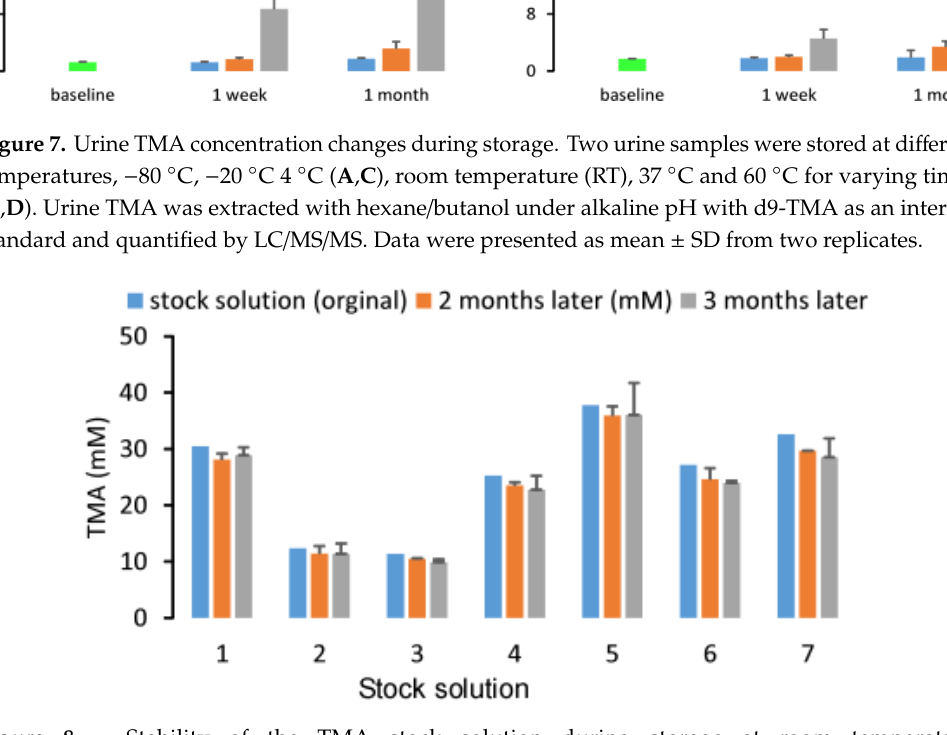
Figure 9. Urine TMA concentration changes during storage after acidification at −80 °C or at room temperature (RT). The HCl added to urine has a final concentration of 60 mM. Data were presented as mean±SD from two replicates.